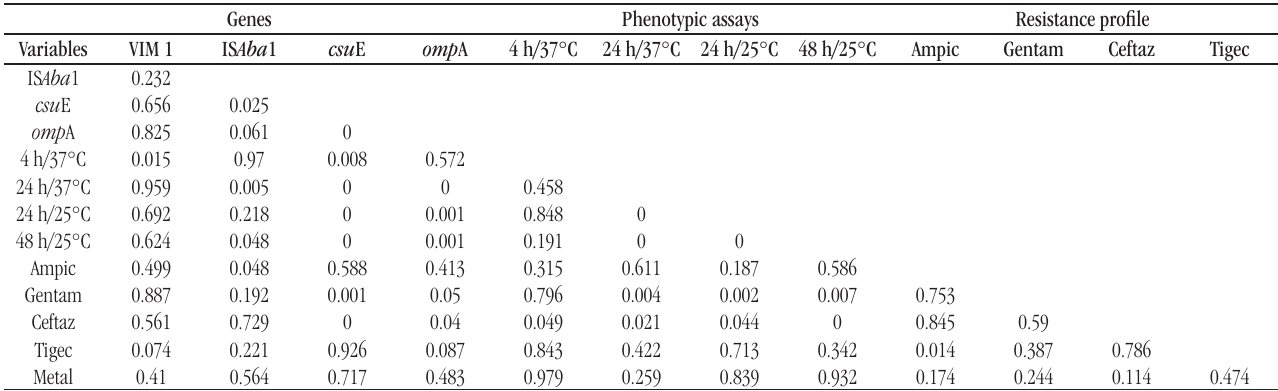
taBLE 3 − p -values obtained by linear association